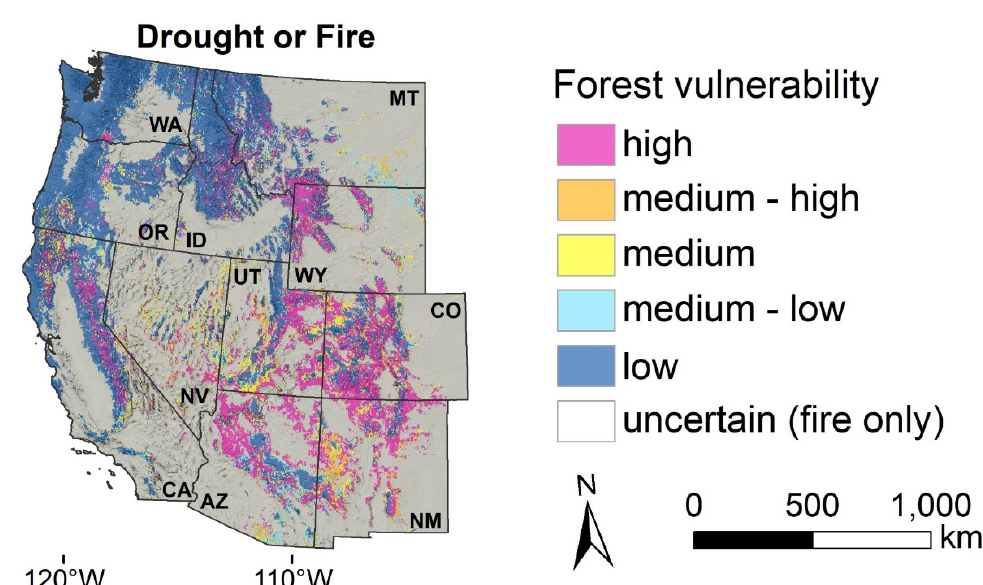
Figure 4. Forestlands that are currently preserved, and additional areas identified as high priority for protection of biodiversity and forest carbon for climate mitigation across the western U.S. Adapted from [5].